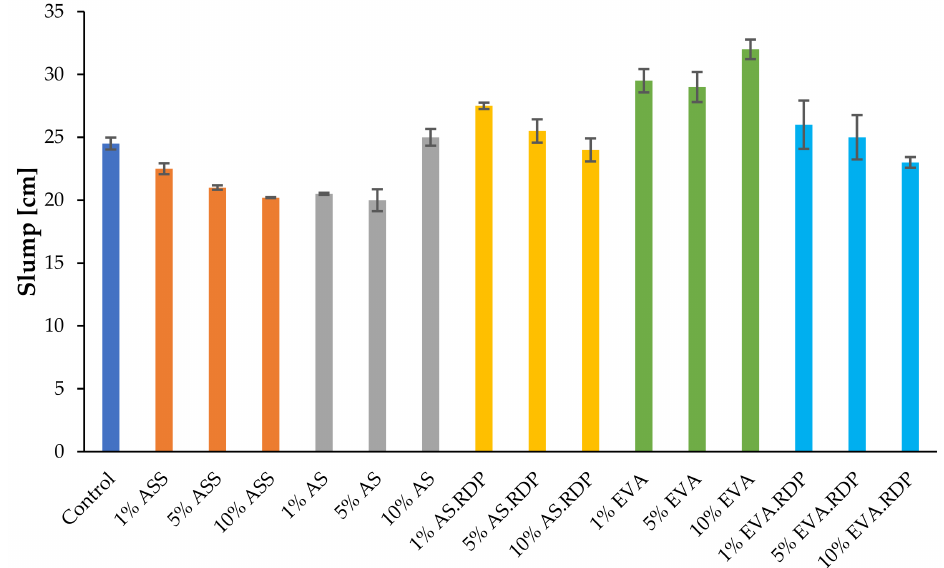
Figure 4. Workability of polymer-modified rubberised concrete.